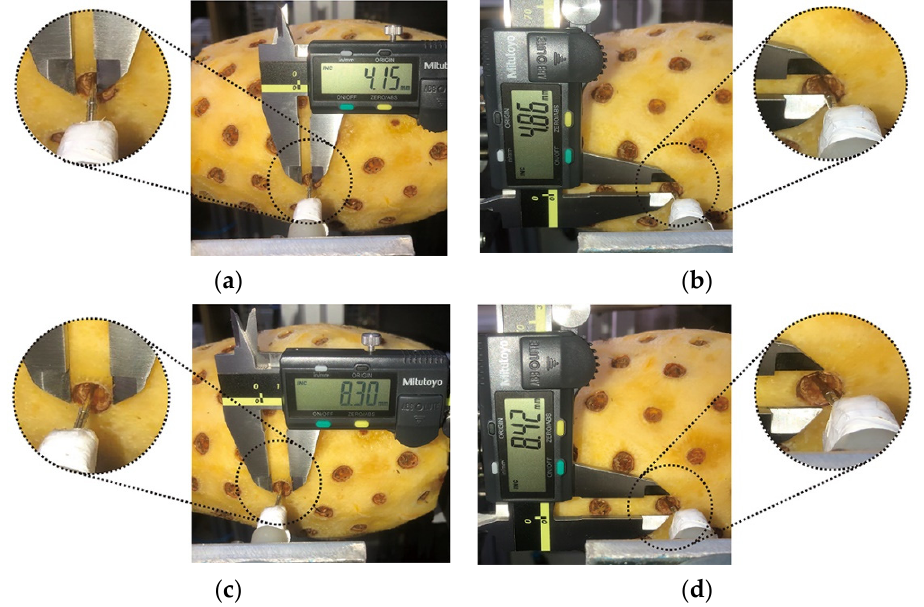
Figure 10. Measurement principle of the probe position error. 1. pineapple eye, 2. probe, and 3. pineapple eye center point.